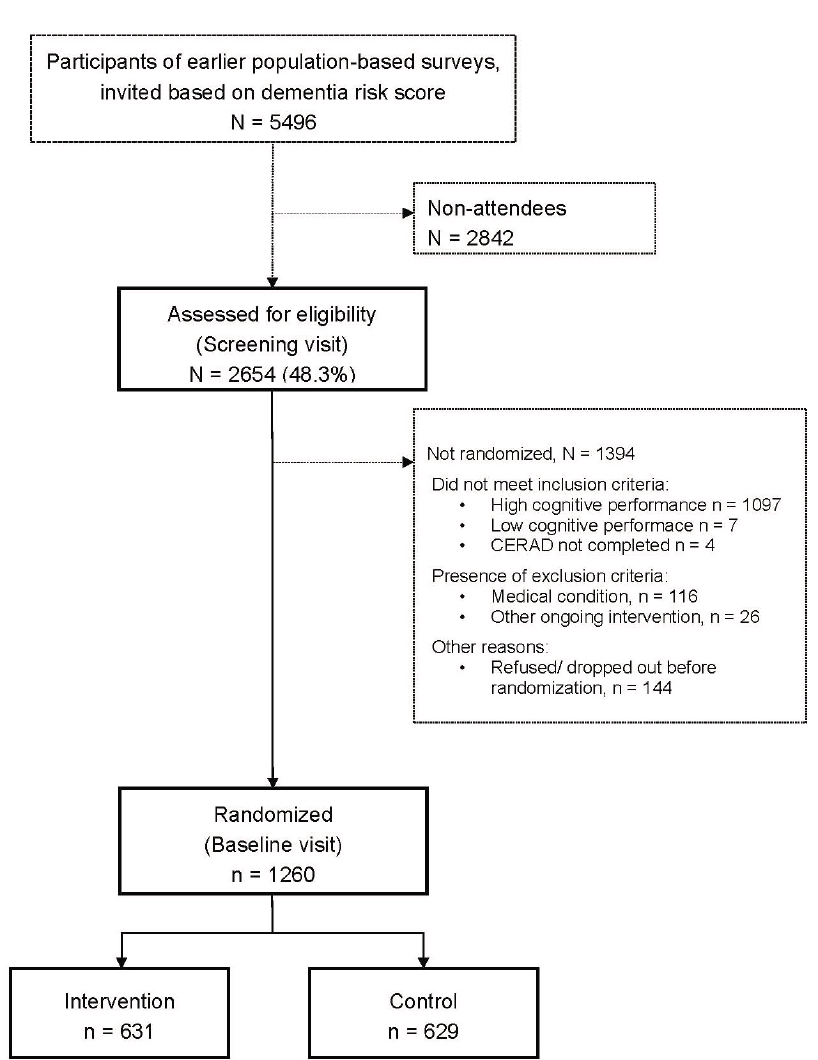
Figure 2. Formation of the study